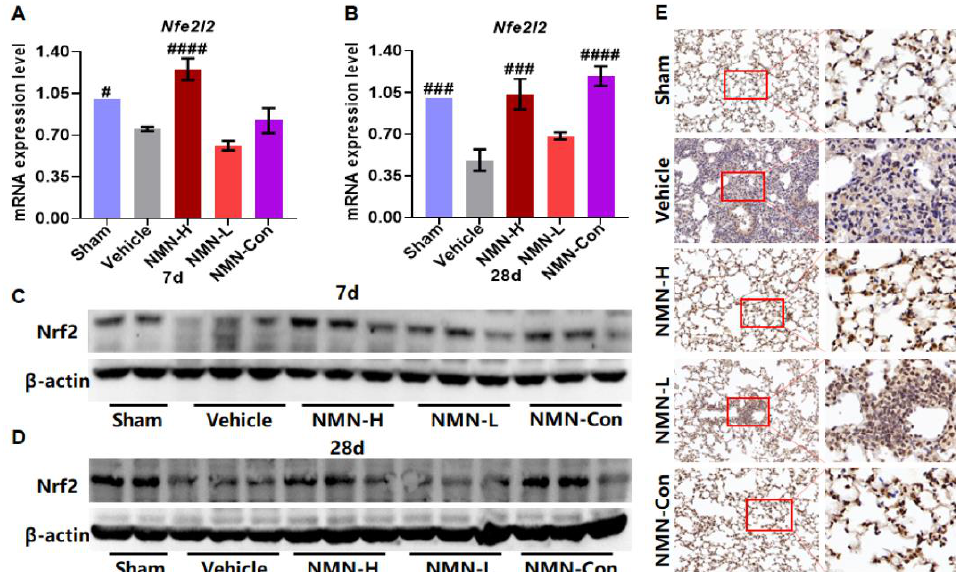
Figure 7. NMN regulates the expression of Nrf2 in silica-induced lung injury. ( A ) The relative expression of Nfe2l2 mRNA in lung tissue at 7 d; ( B ) relative expression of Nfe2l2 mRNA in lung tissue at 28 d; ( C ) expression of Nrf2 protein in lung tissue at 7 d; ( D ) expression of Nrf2 protein in lung tissue at 28 d; ( E ) expression and distribution of Nrf2 in lung tissue detected by immunohistochemical staining. Scale: 20 × , 63 × . # indicates p < 0.05, ### p < 0.001, #### p < 0.0001 vs. Vehicle. Sham: saline + saline; Vehicle: silica + saline; NMN-H: silica + NMN (1000 mg/kg); NMN-L: silica + NMN (500 mg/kg); NMN-Con: saline + NMN (1000 mg/kg).